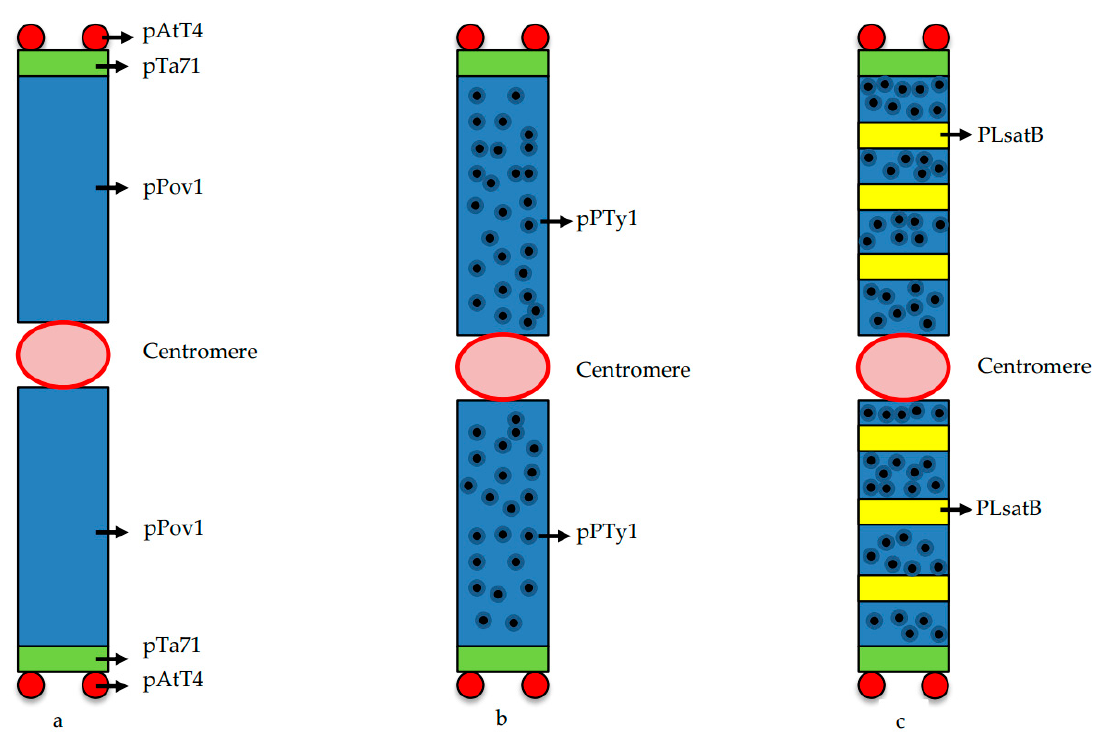
Figure 1. Deducing the composition of B chromosome in Plantago lagopus using FISH. ( a ) FISH signals reported on B chromosome using probes pTa71 (45S rDNA), pAtT4 (Telomere) and pPov1 (5S rDNA) [12]. Note painting of B chromosome by pPov1. ( b ) FISH signals for Ty-1 Copia elements reported over the entire length of B chromosome using probe pPTy1 [10]. ( c ) Specific localization of B specific satellite sequence, PLsatB using FISH on B chromosome [35]. FISH: Fluorescence in situ hybridization; rDNA: Ribosomal DNA.